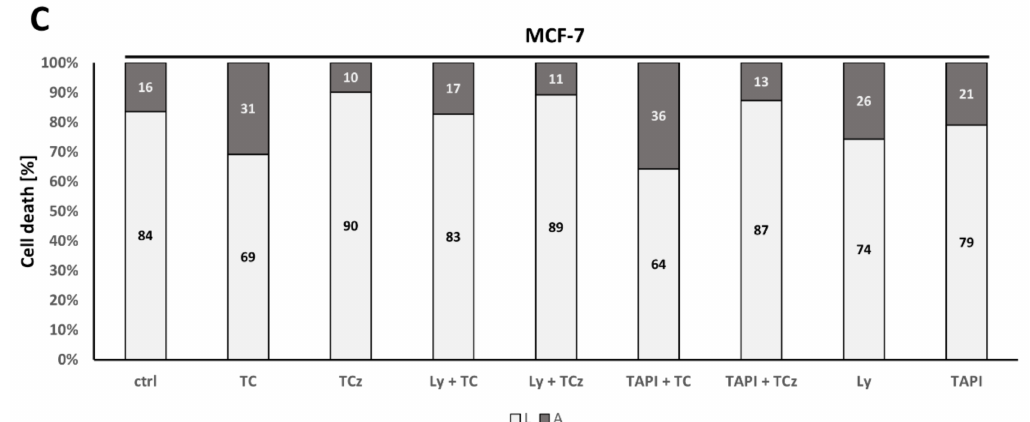
Figure 7. Analysis of the role of γ -secretase for cell death induction in U937 Jurkat and ADAM17 in MCF-7 cells. Flow cytometry based quantification of cell death triggered in ( A ) U937 and ( B ) Jurkat is shown. Where indicated, cells were incubated for 20 h in the presence of T, TC, TCz and the inhibitors of γ -secretase activity Avagacestat (Ava) and Ly-411575 (Ly). Inhibitors were added 30 min prior to addition of TNF. The percentages of living (L, white), apoptotic (A, grey) and necroptotic (N, black) cells are shown. ( C ) Cell death in MCF-7 cells was quantified in the presence of Ly and the ADAM17 inhibitor TAPI-0. The percentages of living (L, white) and apoptotic (A, grey) cells are shown, as MCF-7 cells do not undergo necroptosis due to their lack of